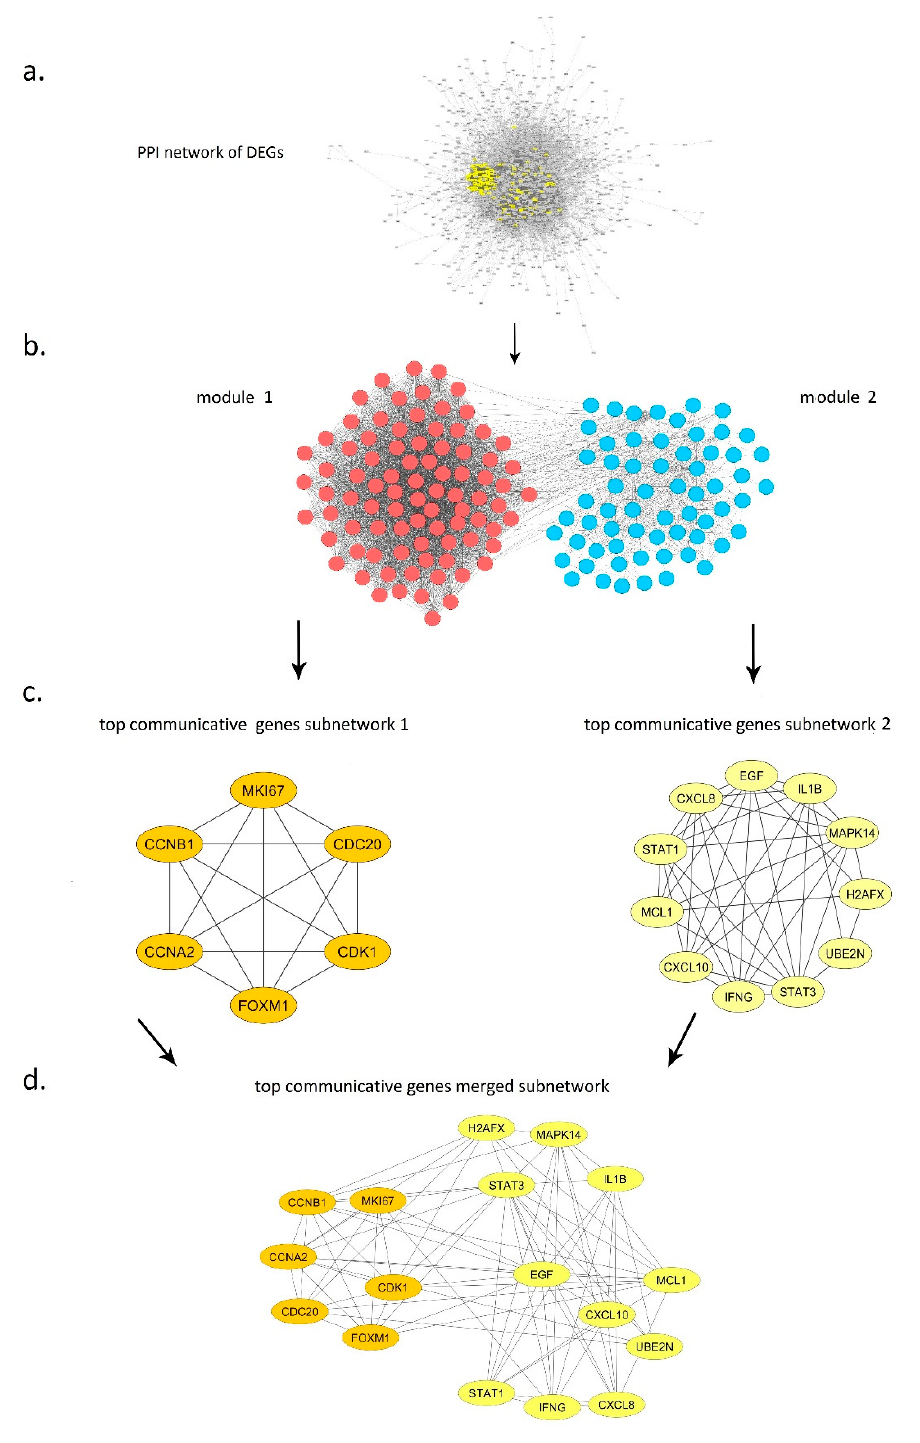
Figure 4. Network analysis results. ( a ) Main component of PPI network of DEGs among 18 components. Selected yellow nodes indicate primary communicative genes based on micro-level network analysis. ( b ) Modularity detection on primary communicative genes PPI network: colors red and blue indicate module 1 and 2 (related to cell cycle and immune system genes), respectively. ( c ) Top communicative genes subnetworks for each module. ( d ) Inter-module top communicative genes subnetwork.